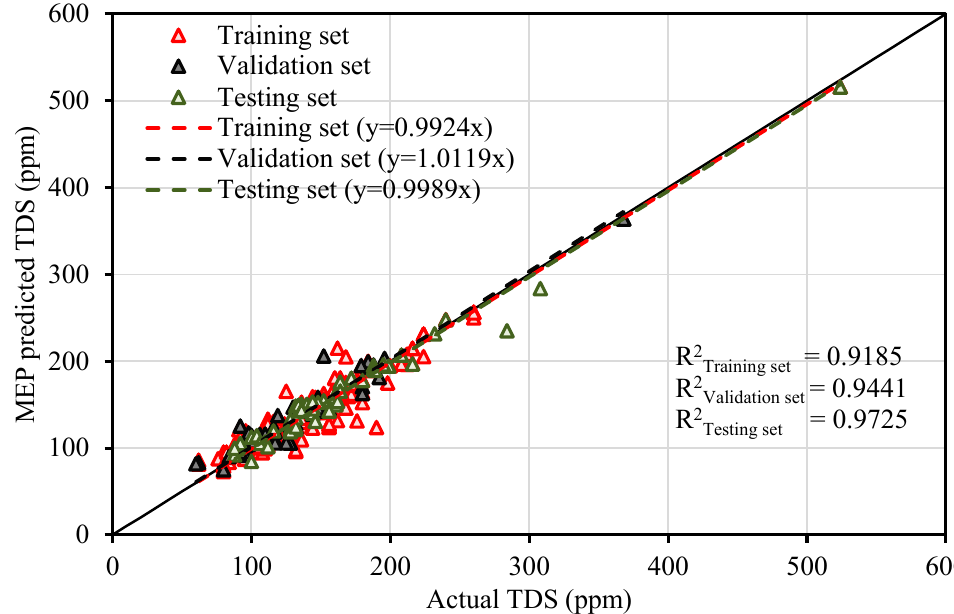
Figure 3. Regression plot of MEP models established for TDS.